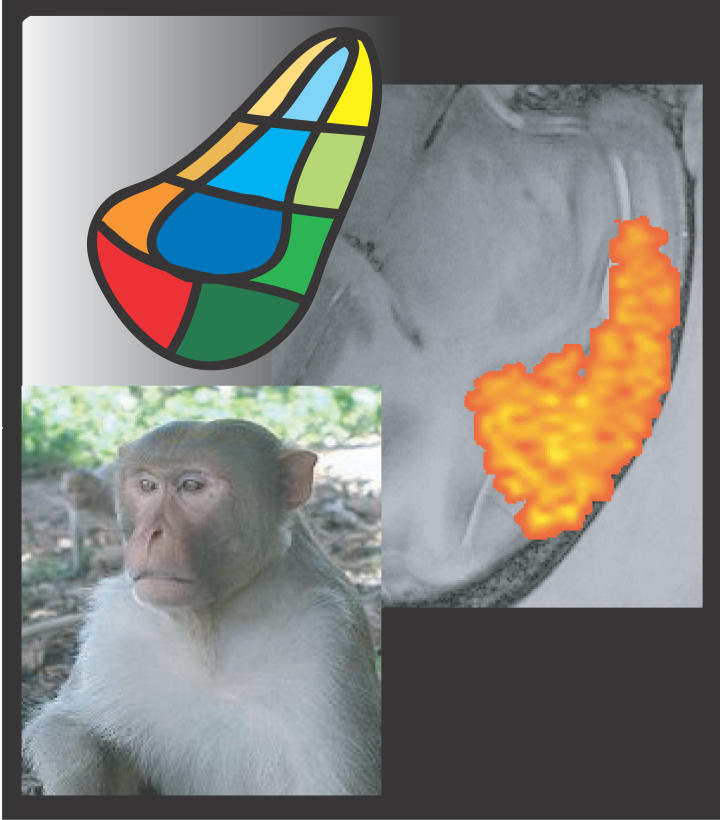
Non-invasive functional imaging reveals many discrete functional areas in the auditory cortex of a non-human primate. (Photo: Marc D. Hauser)